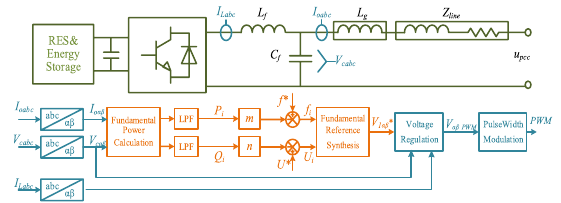
Fig. 2 Schematic diagram of the droop control